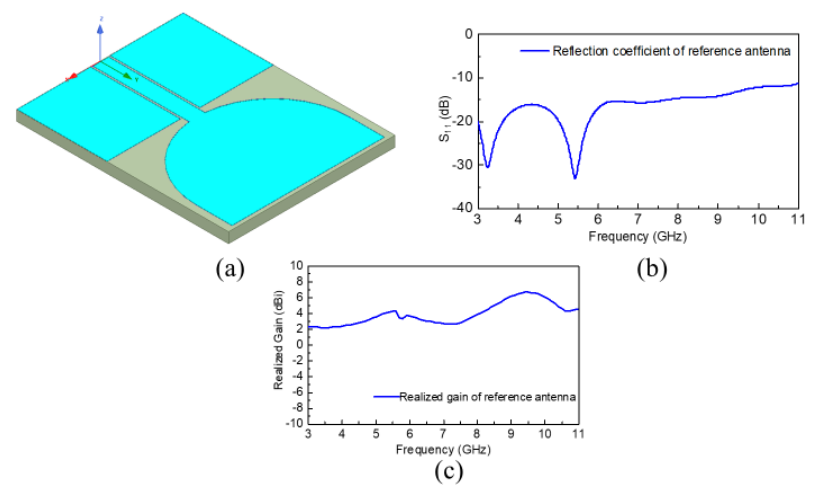
Figure 1. Reference wide-band antenna; ( a ) Geometry of reference wide-band antenna; ( b ) Reflection coefficient of reference wide-band antenna; ( c ) Realized gain of reference wide-band antenna.